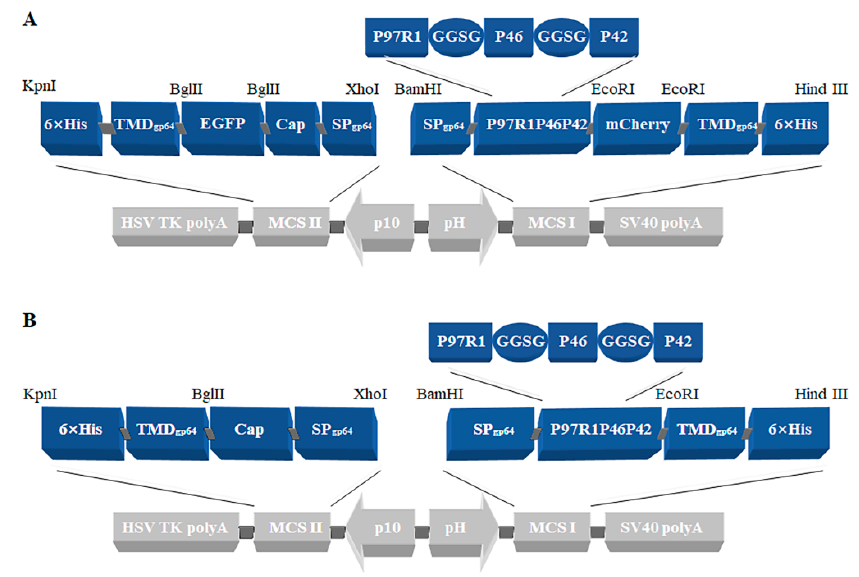
Figure 1. Map of recombinant vectors: ( A ) pFastBac dual-P97R1P46P42-mCherry-Cap-EGFP ; ( B ) pFastBac dual-P97R1P46P42-Cap.